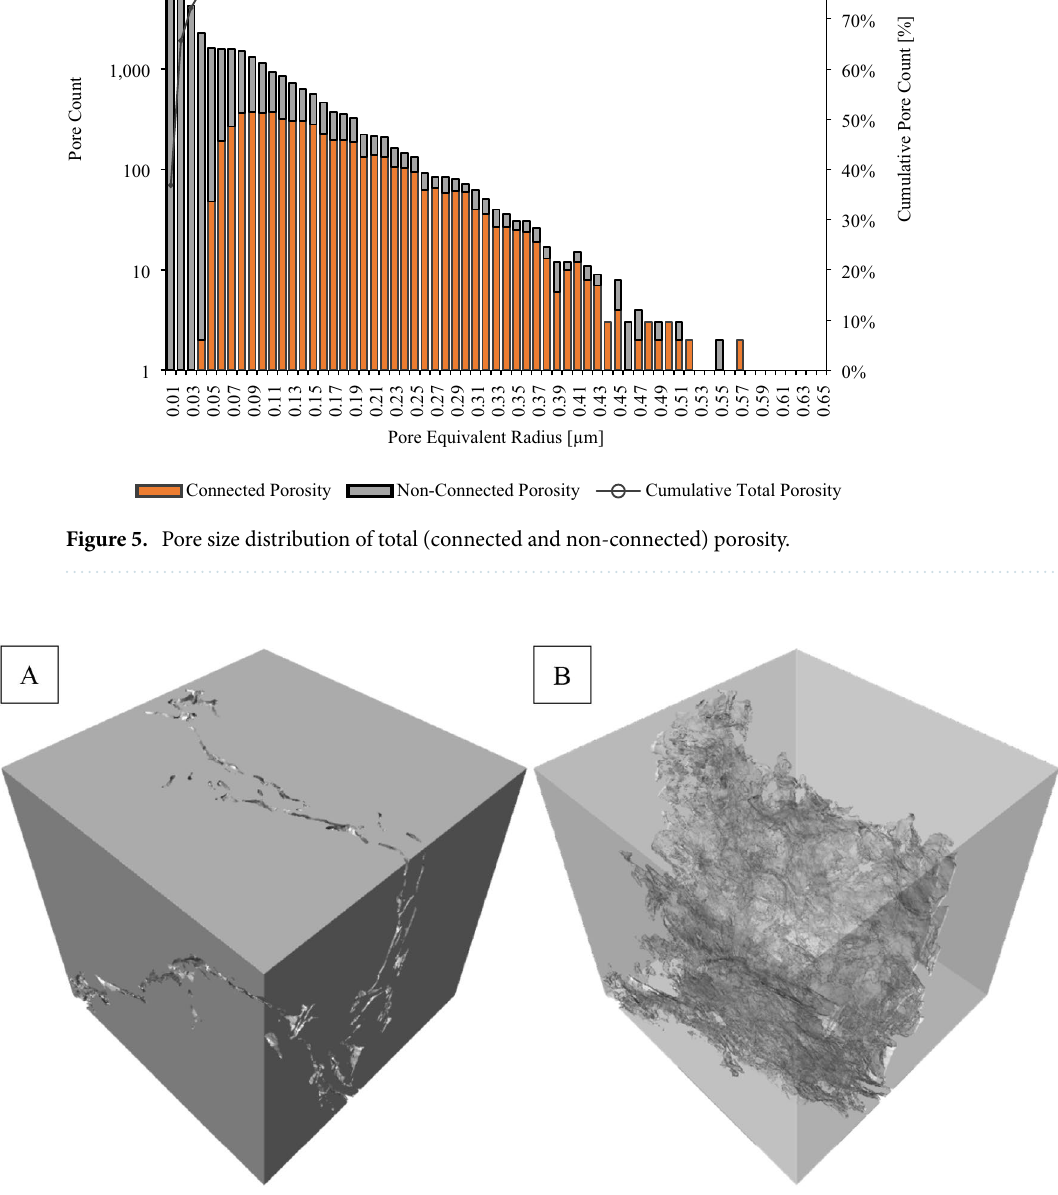
Figure 6. ( A ) External and ( B ) internal surface mesh of the inverted and up-scaled (10×) 3D model of the connected